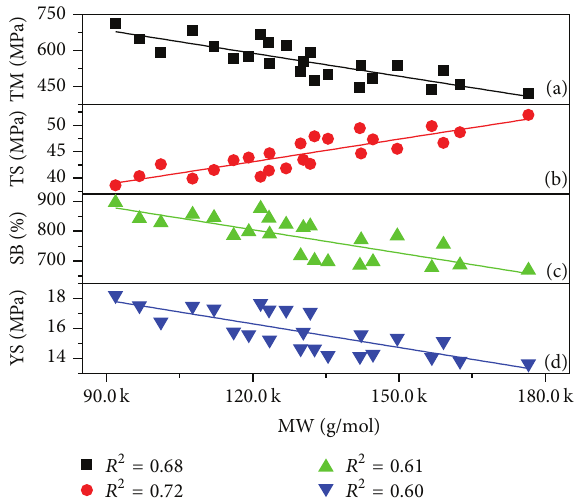
Figure 7: Correlation plots of MW with TM (a), TS (b), SB (c), and YS